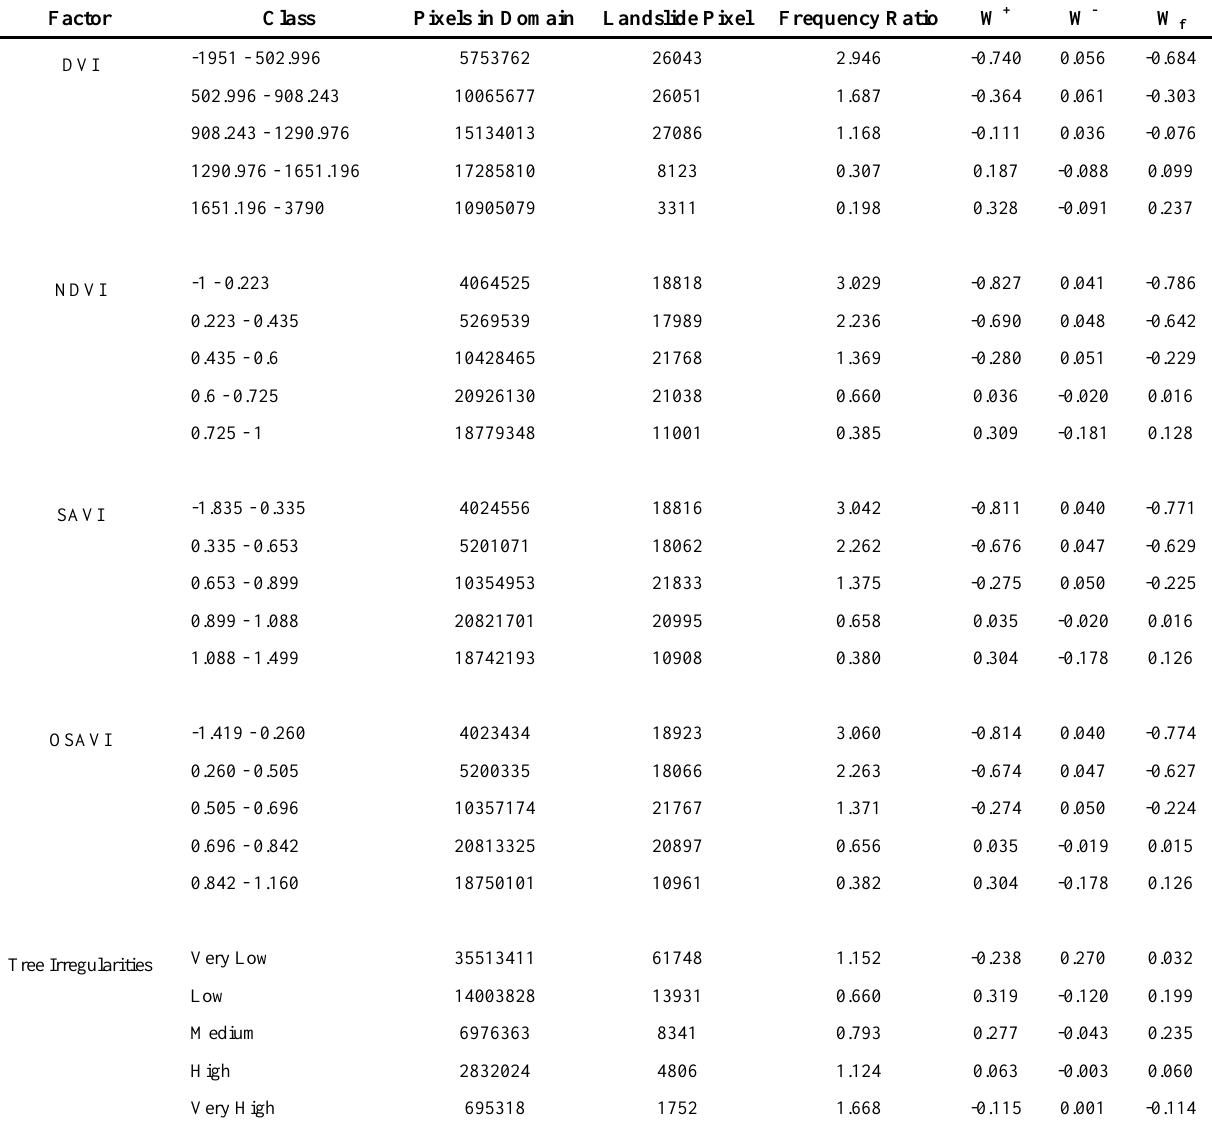
Table 1. Spatial relationship between each indicator and the landslides for the FR and WoE (active landslide)